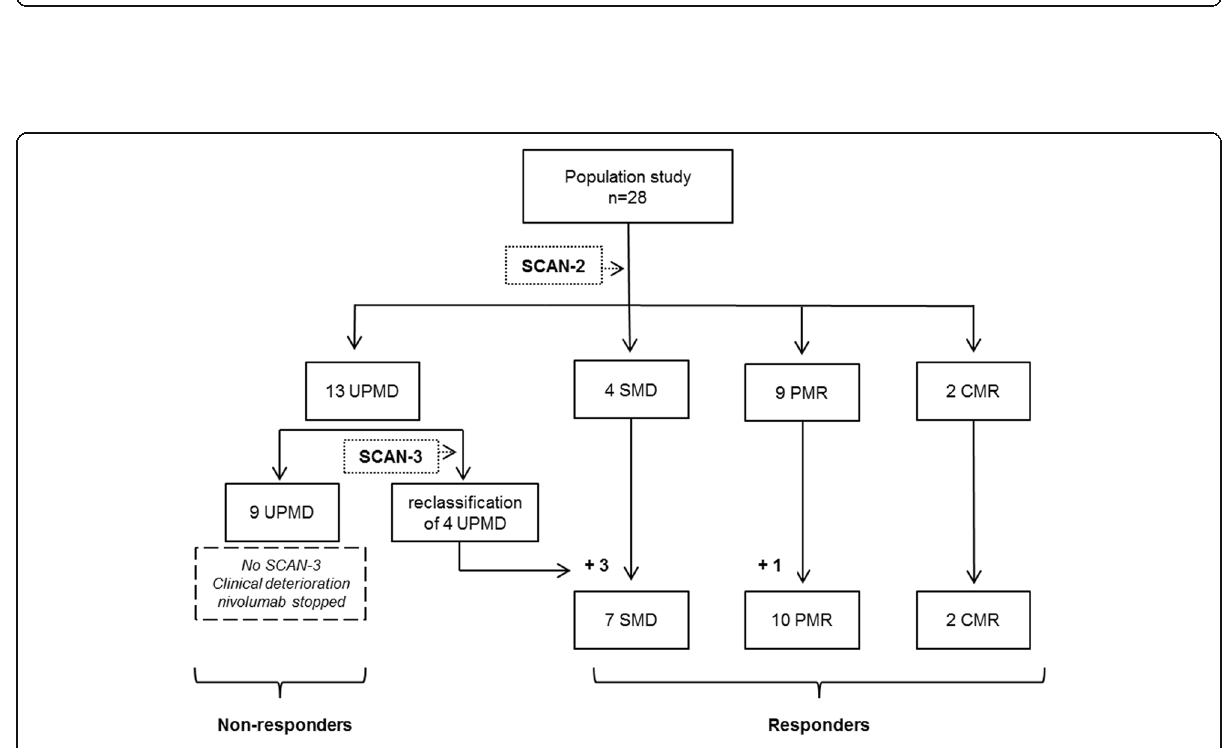
Fig. 4 Category of imaging response according to